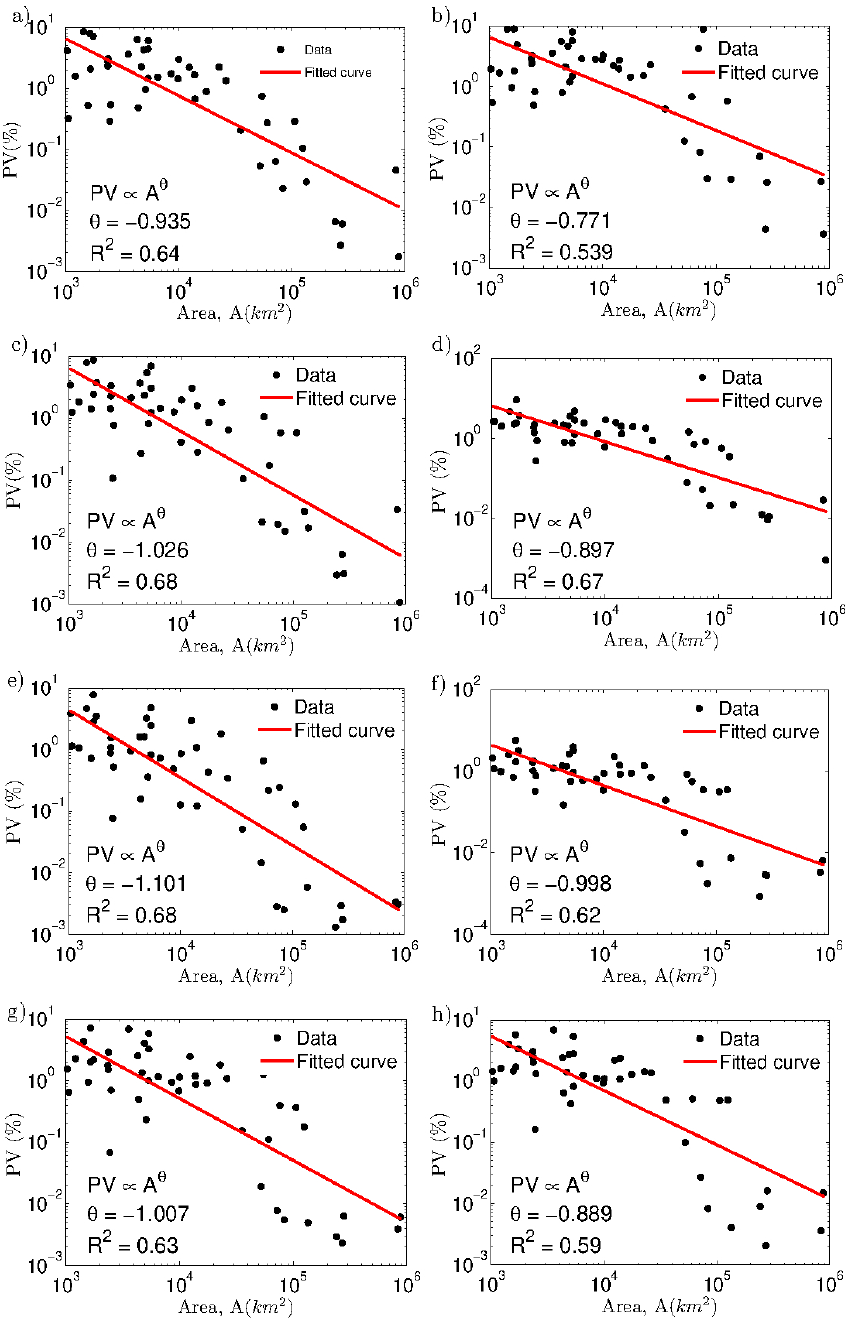
Figure 9. Seasonal percentages of variances explained by the IMFs for streamflows versus areas of the river basins. (Left column) IMF2 and (right column) IMF3. ( a , b ) DJF; ( c , d ) MAM; ( e , f ) JJA; ( g , h )